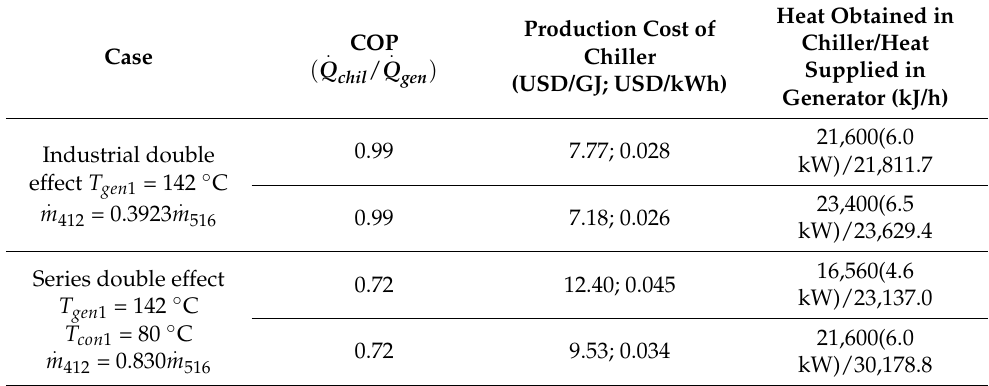
Table 13. COP and production cost of chilled water for double-effect LiBr–water refrigeration systems.